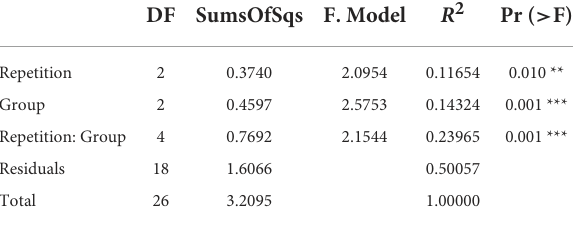
TABLE 2 Number of differentially abundant OTUs in the pairwise